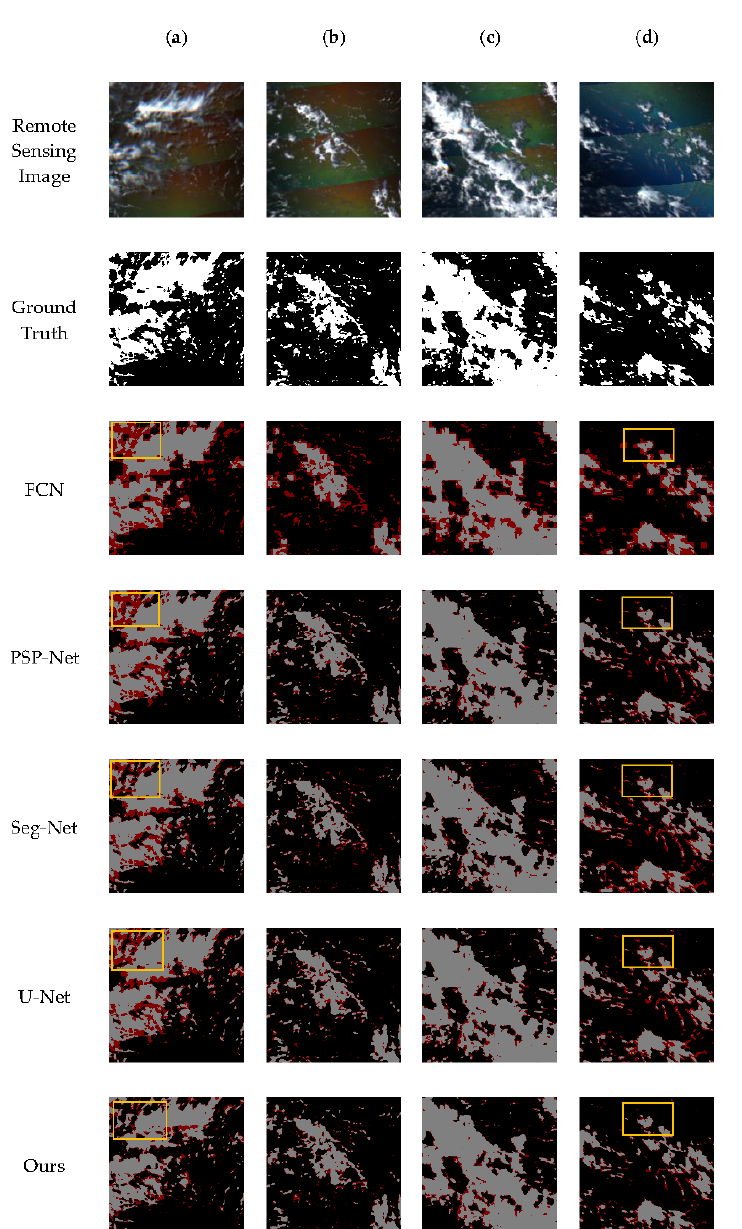
Figure 8. Visual comparison of cloud detection. ( a – d ) are the four images randomly selected by us to show the test results. FCN, PSP-Net, Seg-Net, U-Net and ours respectively represent the cloud detection results of the four groups of comparison experiments we set and the cloud detection results of the proposed method. Gray represents the clouds, black represents the background, and red represents the pixels where the prediction was wrong. In ground truth, white represents the cloud, and black represents the